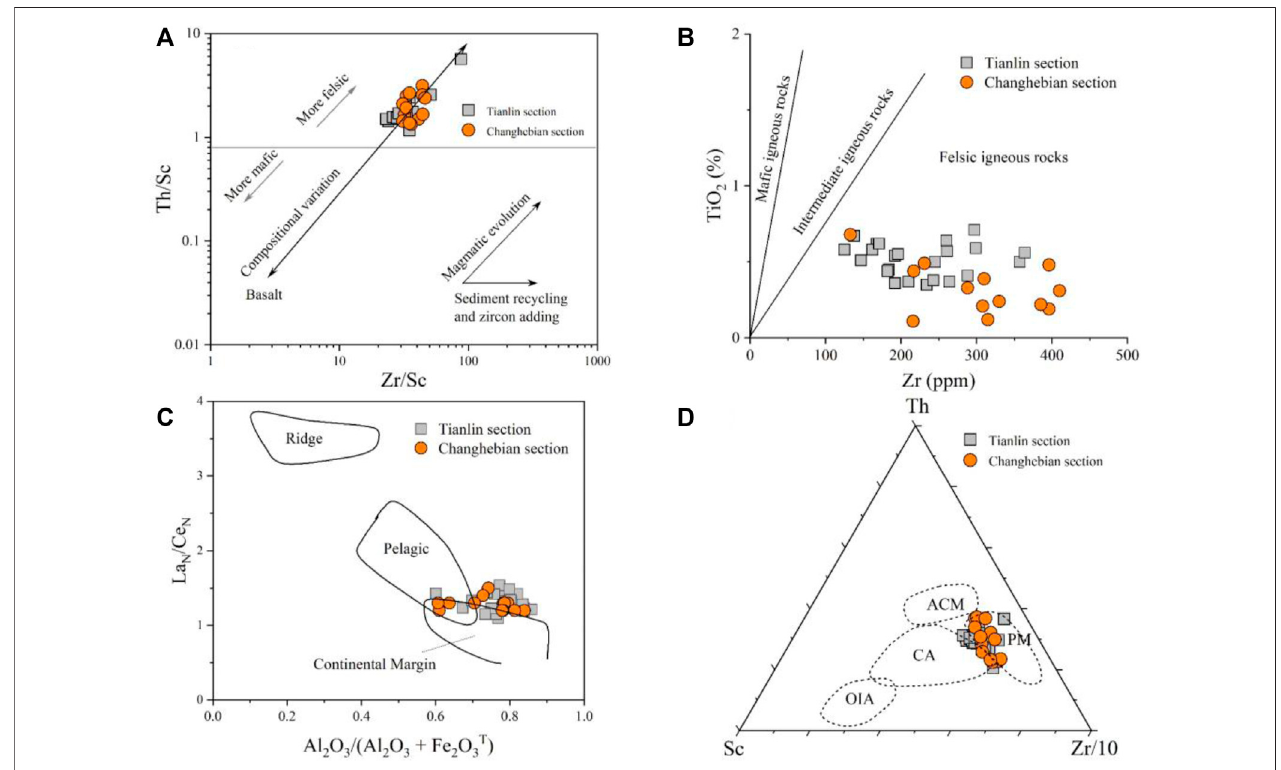
FIGURE 6 | Sedimentary provenance for the Changhebian and Tianlin sections: (A) Zr/Sc versus Th/Sc, (B) Zr versus TiO 2 , (C) Al 2 O 3 /(Al 2 O 3 +Fe 2 O 3 ) versus La N / Ce N , and (D) Th-Sc-Ze/10 ternary diagram. CA, continental island arc; ACM, active continental margin; OIA, oceanic island arc; PM, passive margin.